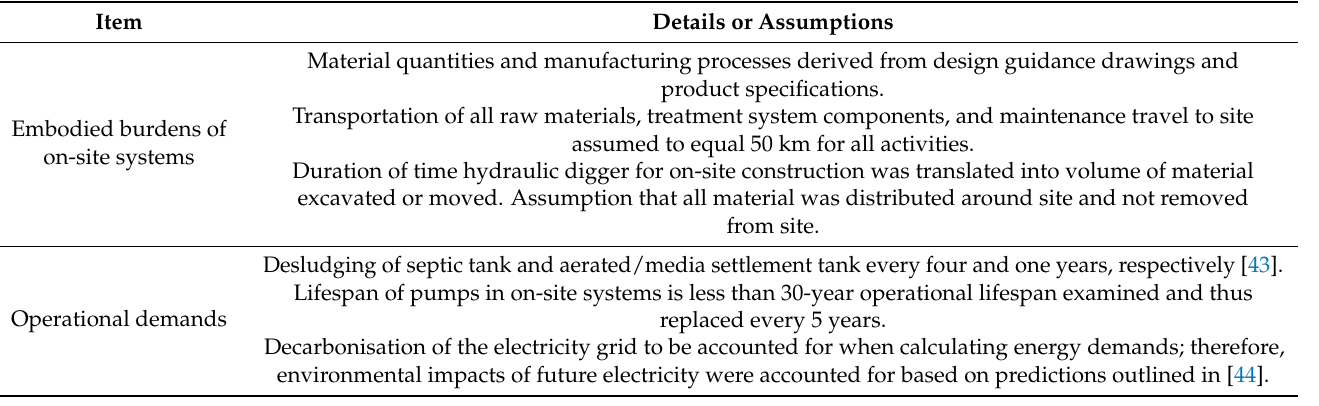
Table 2. Key inventory data and associated details or assumptions taken as part of the LCA process for the DWWTS.